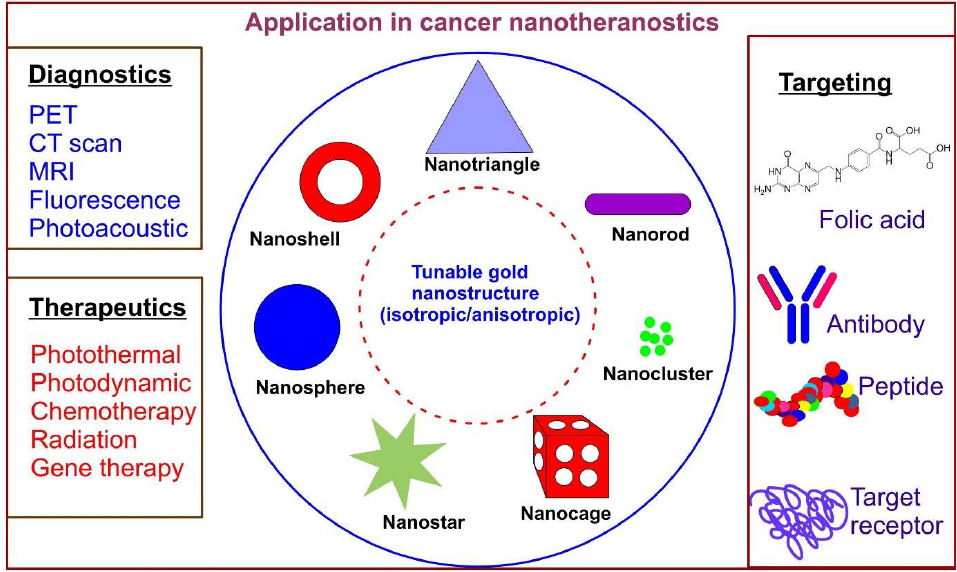
Figure 1. The schematic illustrating the shape by design of tunable gold nanostructures from isotropy to anisotropy through surface modification and their application in cancer